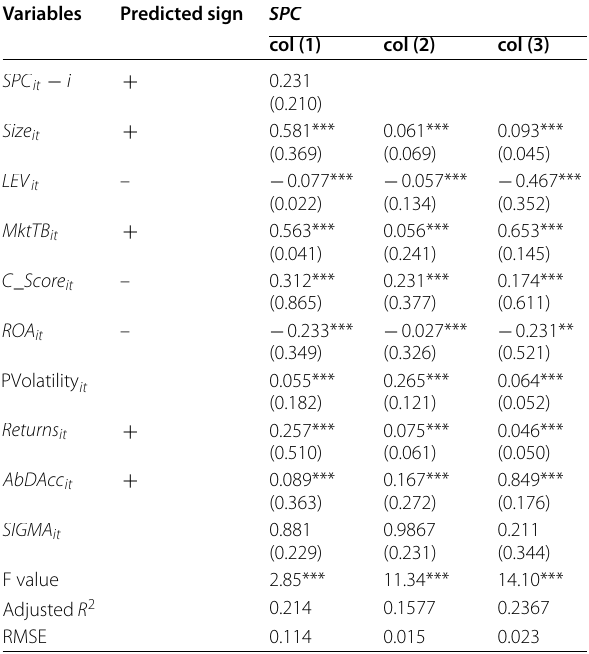
Table 6 Spillover outcome of